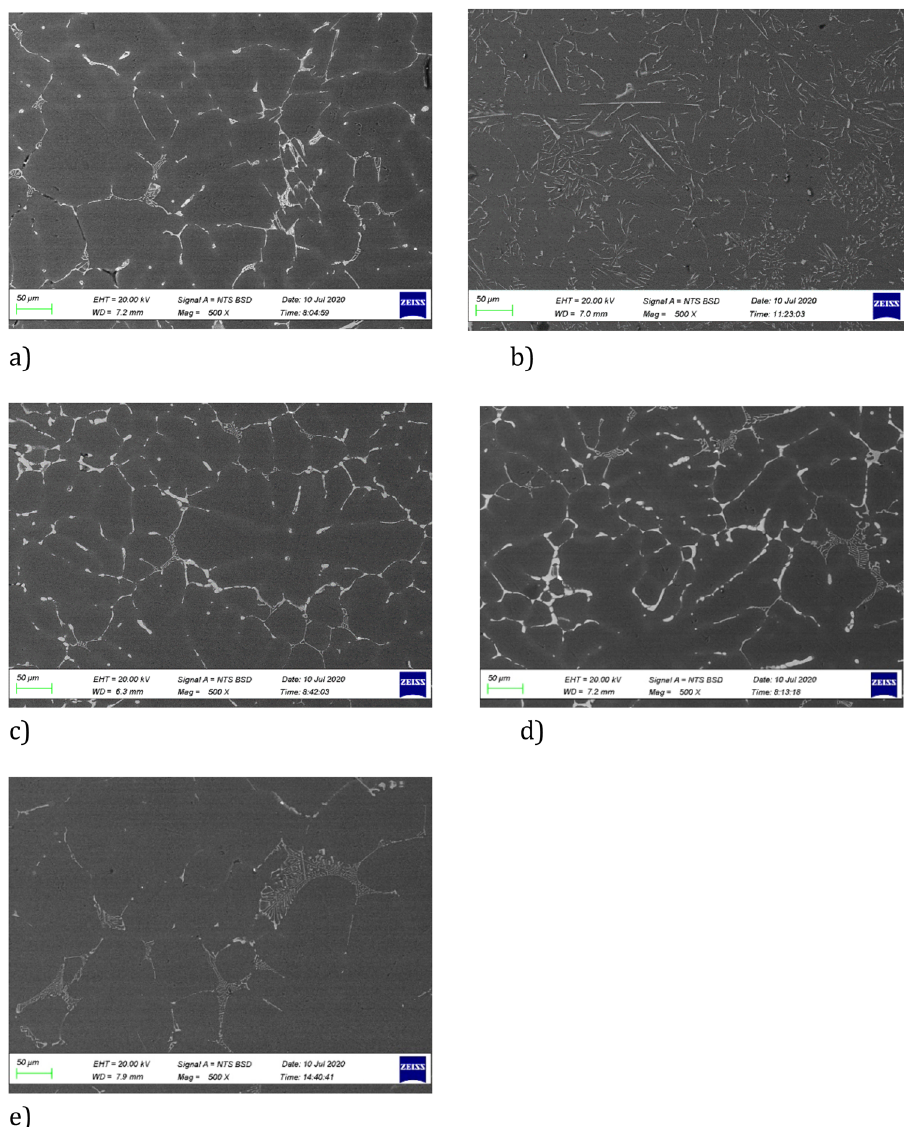
Figure 1: Showing the microstructures of ( a ) Al alloy, ( b ) Al – 4 wt% CuZnAlNi, ( c ) Al – 6 wt% CuZnAlNi, ( d ) Al – 8 wt% CuZnAlNi, and ( e ) Al – 8 wt%